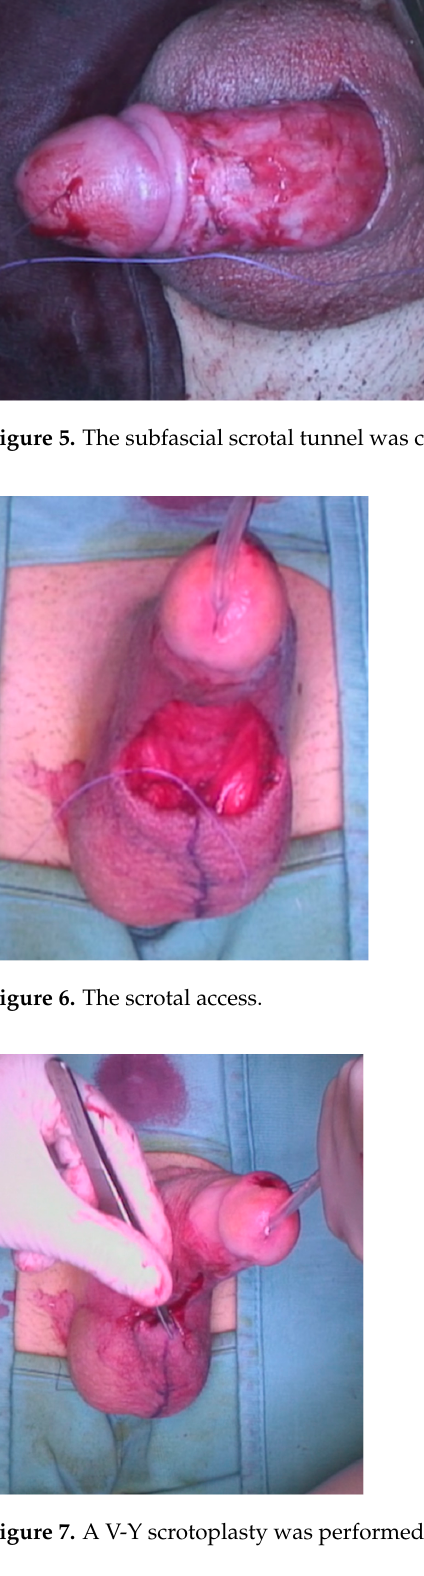
Figure 8. Final result at 6 month follow up.